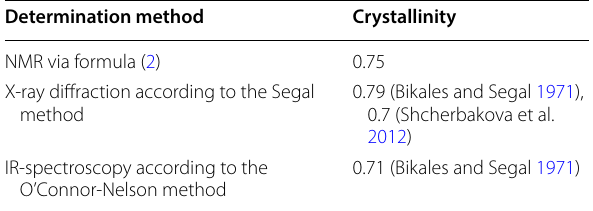
Table 1 The crystallinity of cotton cellulose